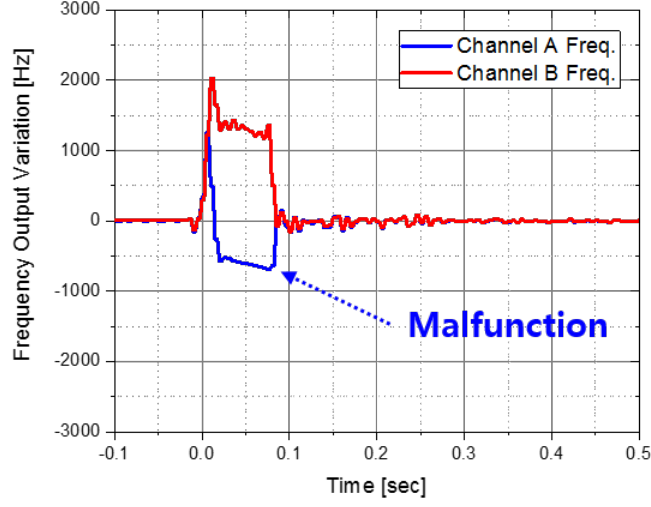
Figure 14. Malfunctioning case of accelerometer.